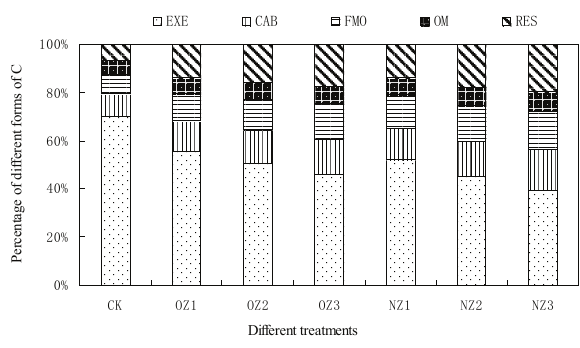
Figure 5: Effects of application of ordinary zeolite and nano zeolite on percentage of different speciation of cadmium in